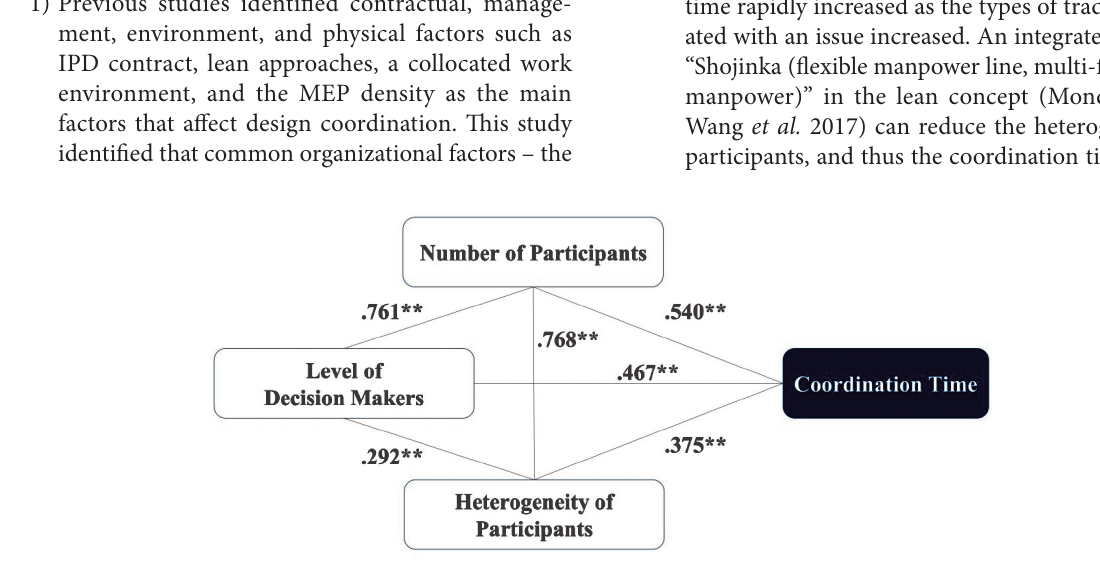
Figure 10. Correlation analysis between issues resolving the coordination time, heterogeneity of participants, number of participants, and level of decision makers ( Note :